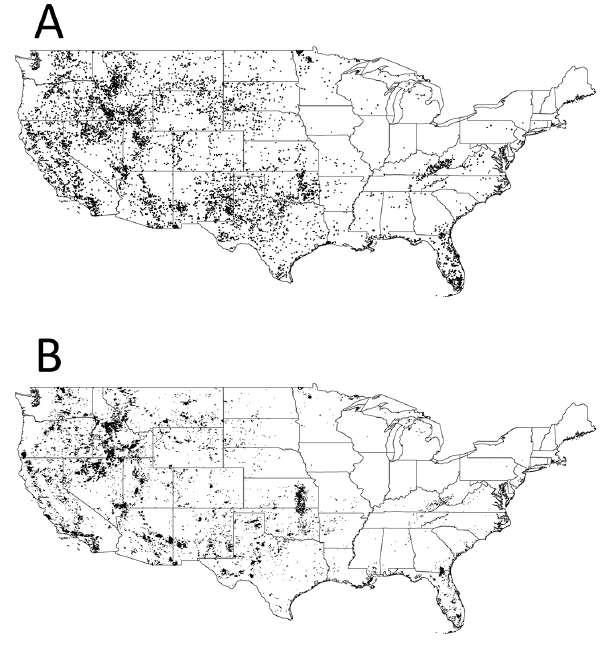
Figure 3. Locations of wildfires in the conterminous US, 1992– 2011, reported as greater than or equal to 405 hectares (A) in the FPA FOD and (B) in the MTBS perimeter data set. The points in panel A are not displayed to scale, but rather at a size that makes it possible to compare the general spatial pattern of large-fire oc- currence as indicated by the FPA FOD to the large-fire perimeters mapped by MTBS for the same